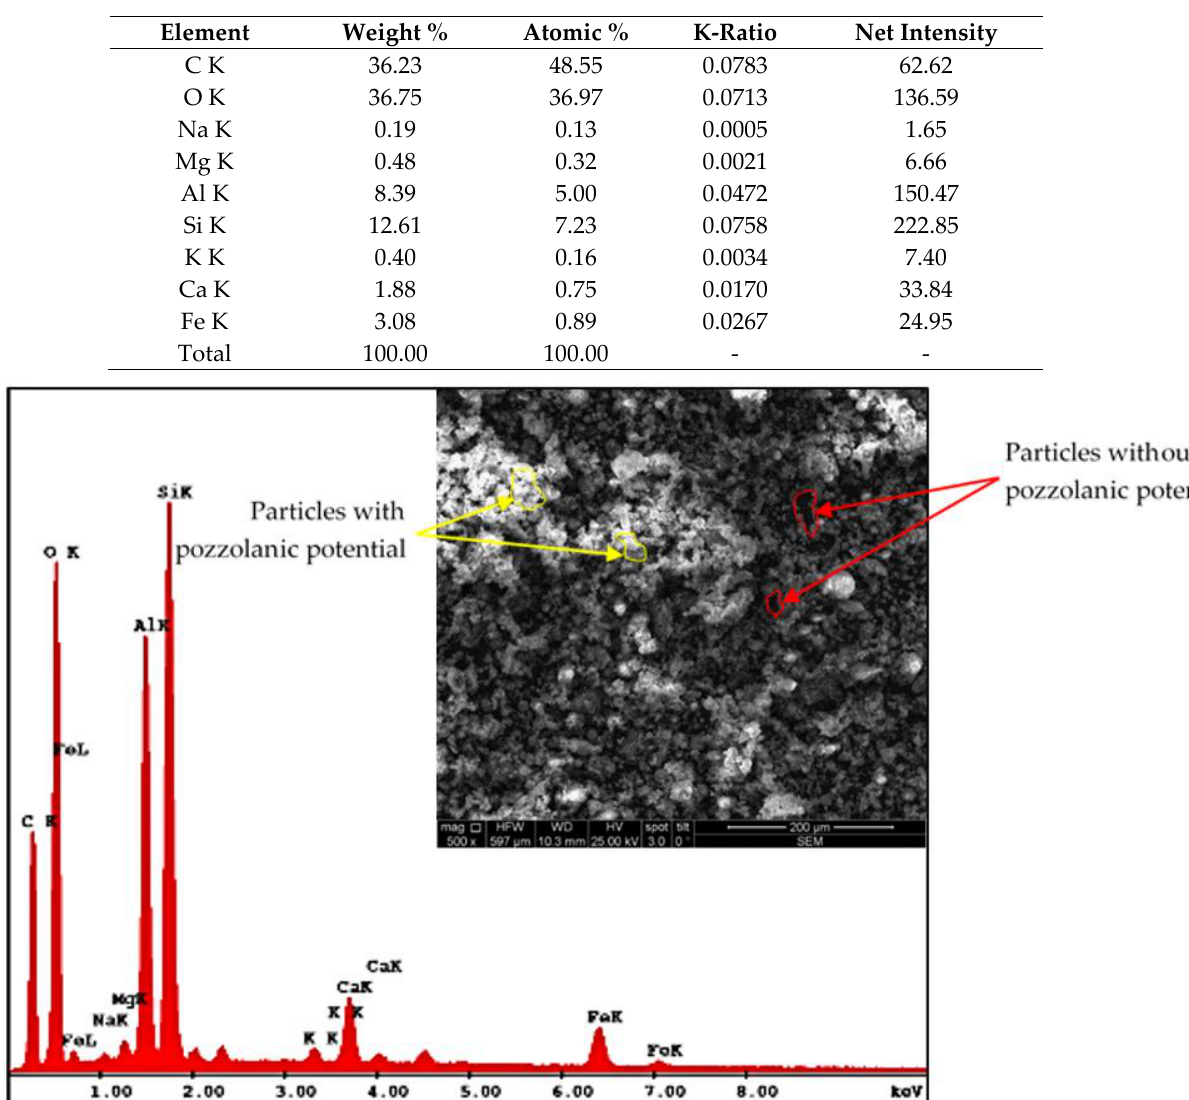
Figure 10. Elementary chemical analysis of fly ash produced by C ET Holboca Iași and SEM image of particles at a magnification rate of 500×.